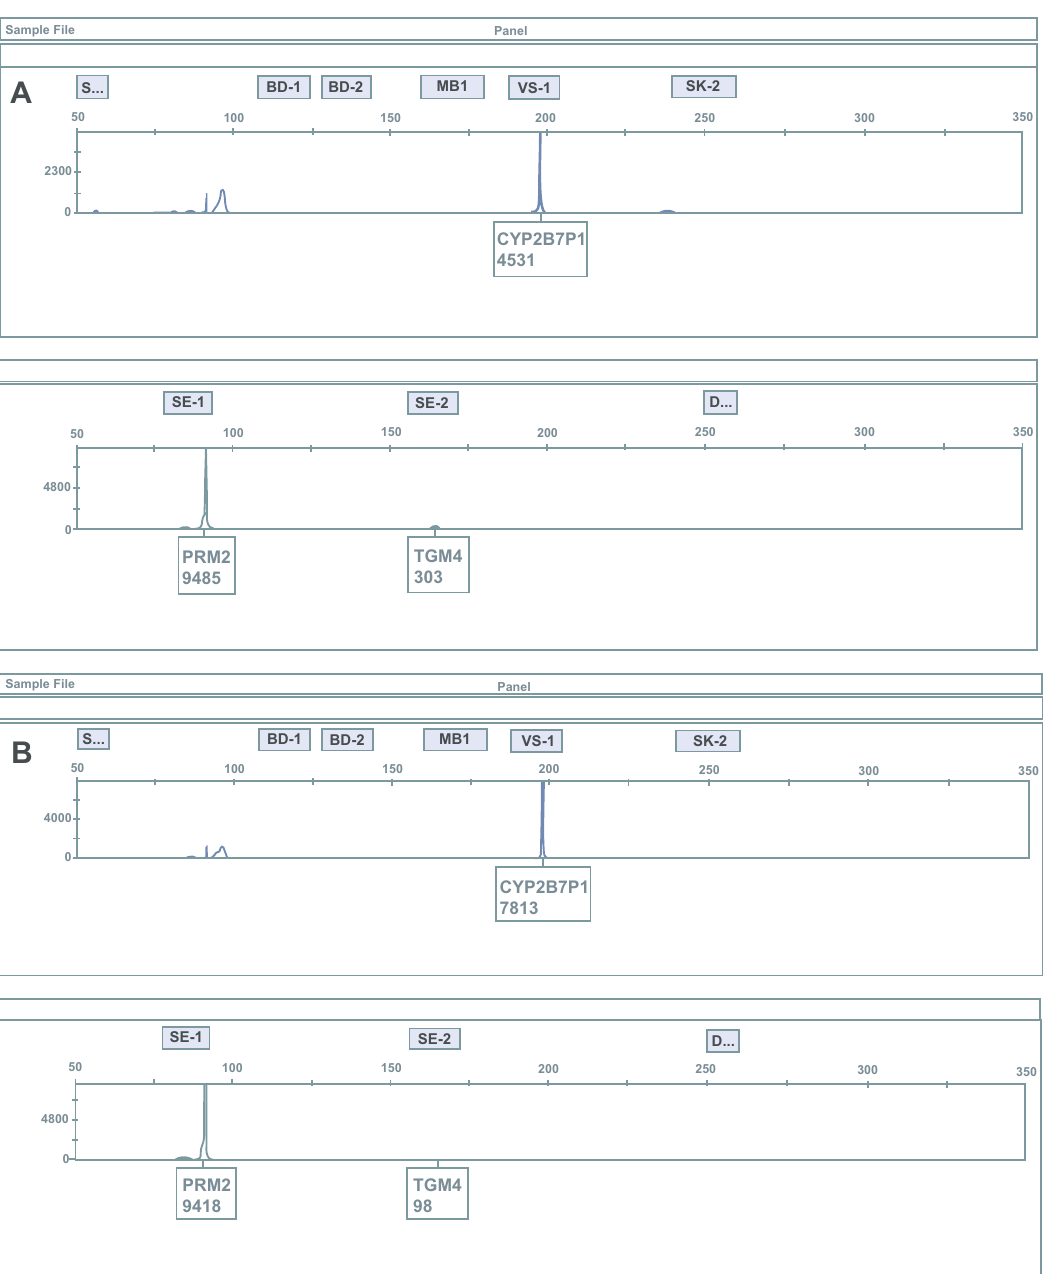
Figure S2. Detection of semen in reportedly single source vaginal samples using a capillary electrophoresis multiple mRNA profiling assay. RT-PCR products from RNA extracted from previously reported single source vaginal secretions samples were amplified in a multiplex reaction using a mRNA profiling assay for body fluid/tissue identification. The multiplex contains mRNA biomarkers for blood, semen, saliva, vaginal secretions, menstrual blood and skin. Shown here are two vaginal samples ( A and B ) in which semen was detected as indicated by the presence of the PRM2 and TGM4 (semen-specific biomarkers). This data is consistent with the detection of semen using the semen-saliva duplex HRM assay. The presence of vaginal secretions is indicated by the presence of CYP2B7P1. The x-axis indicates size in base pairs and the y-axis indicates relative fluorescence units (note: the y-axis scales are different for some panels due to varying signal intensities of the observed products). The grey areas represent the bins for biomarker identification. The biomarker name and relative fluorescence units are